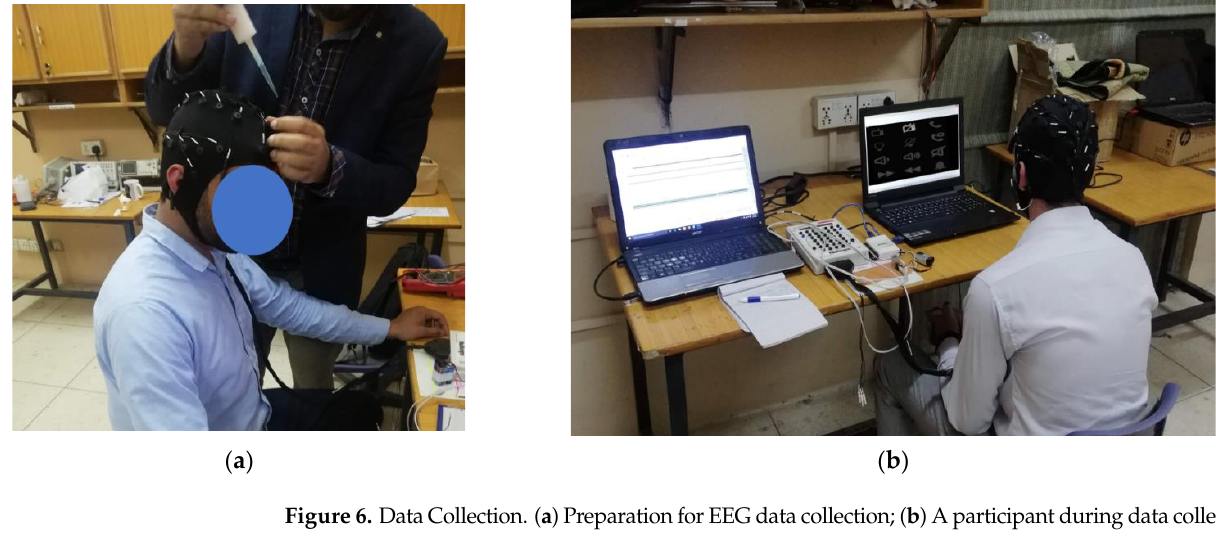
Figure 6. Data Collection. ( a ) Preparation for EEG data collection; ( b ) A participant during data collection.